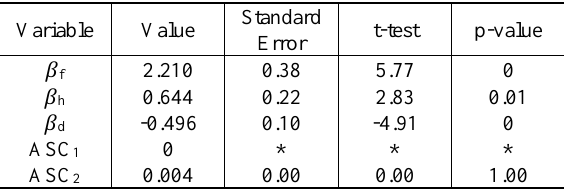
Table 4. DCM Results for scenario 1